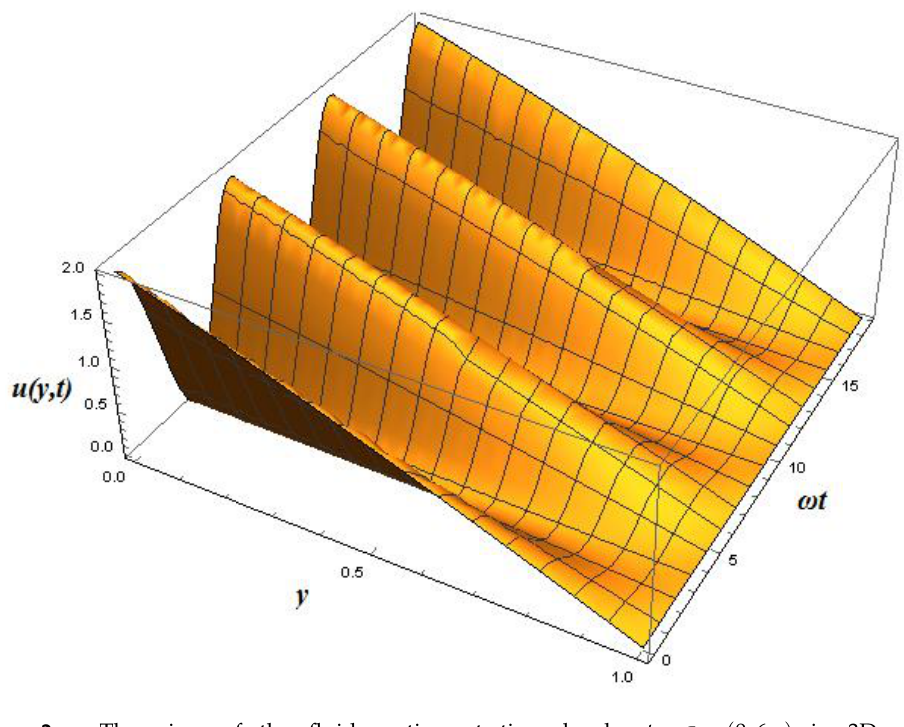
Figure 2. The view of the fluid motion at time level ω t ∈ ( 0,6 π ) in 3D, when m = 0.3, M = 0.2, W e = 0.1